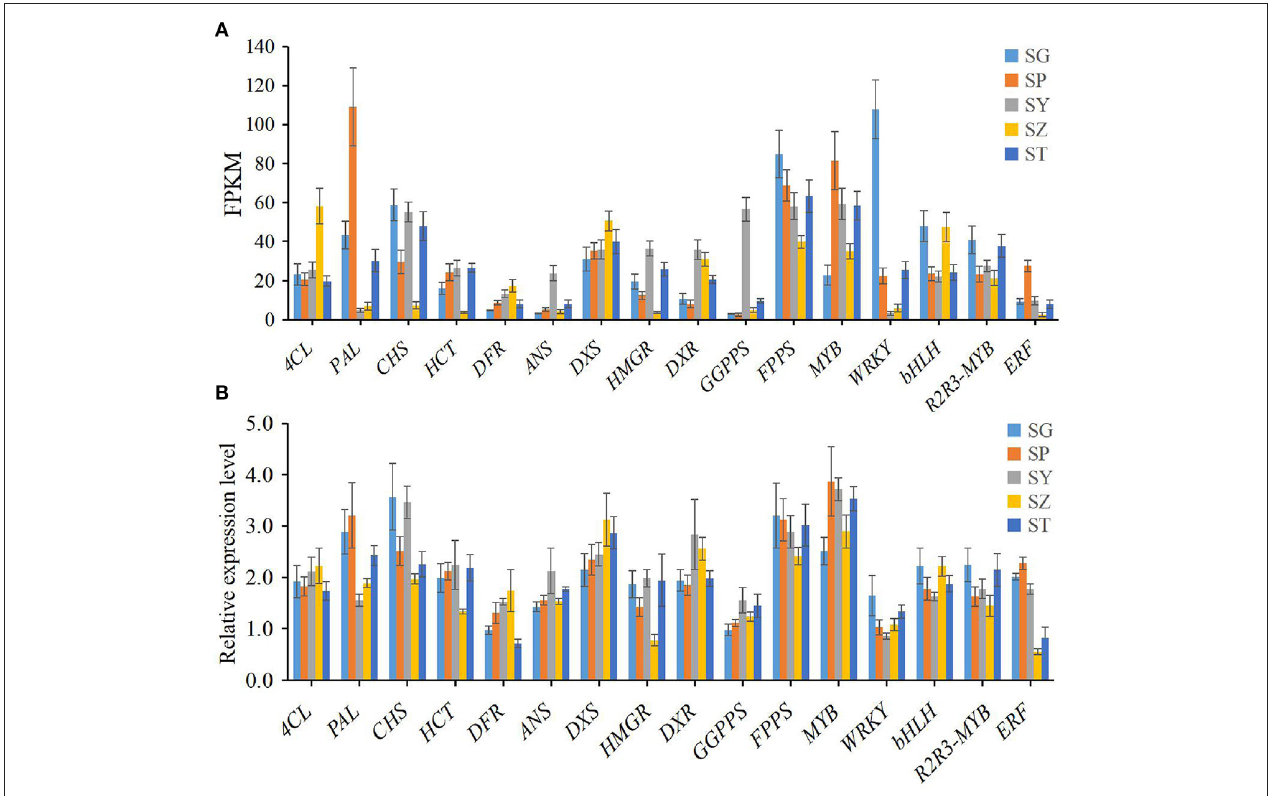
FIGURE 4 | Expression patterns of 16 selected unigenes in different tissues of Pinus taeda. (A) The expression level of 16 unigenes is based on the fragments per kilobase of transcripts per million mapped fragments (FPKM) value. (B) The relative expression level of 16 unigenes obtained by quantitative real-time PCR (qRT-PCR) analysis. The error bars represent the SD from three replicates.